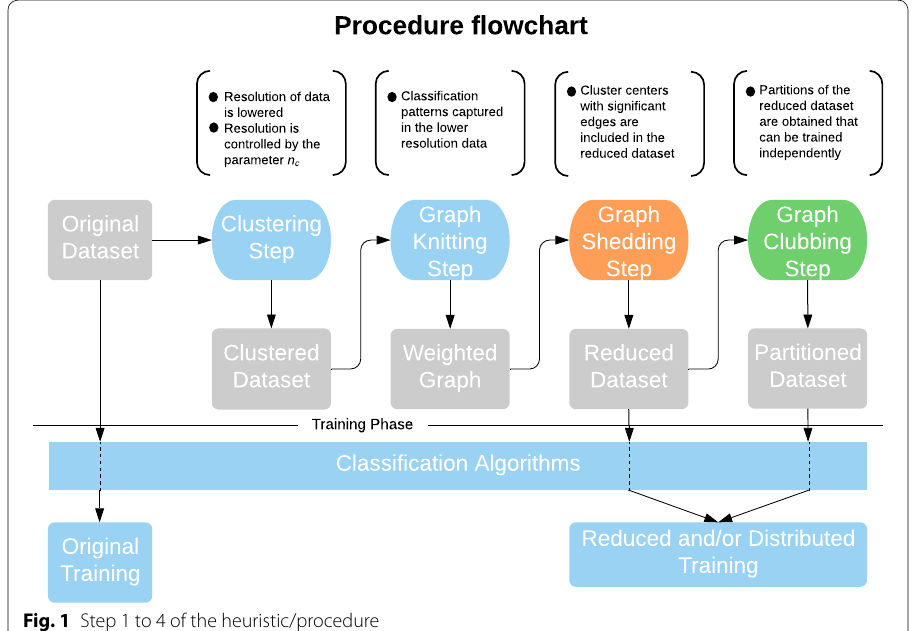
Fig. 1 Step 1 to 4 of the